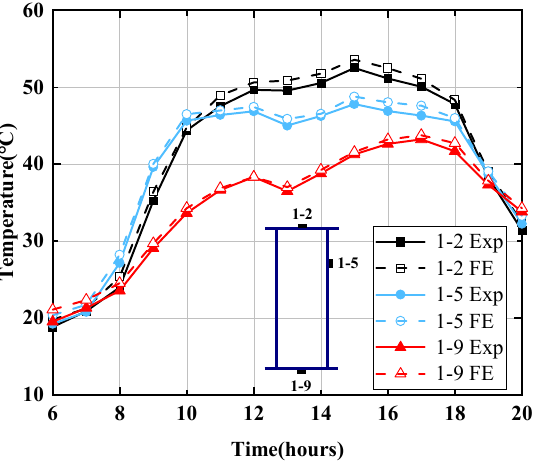
Figure 14. Comparison of finite element simulation values and measured values.